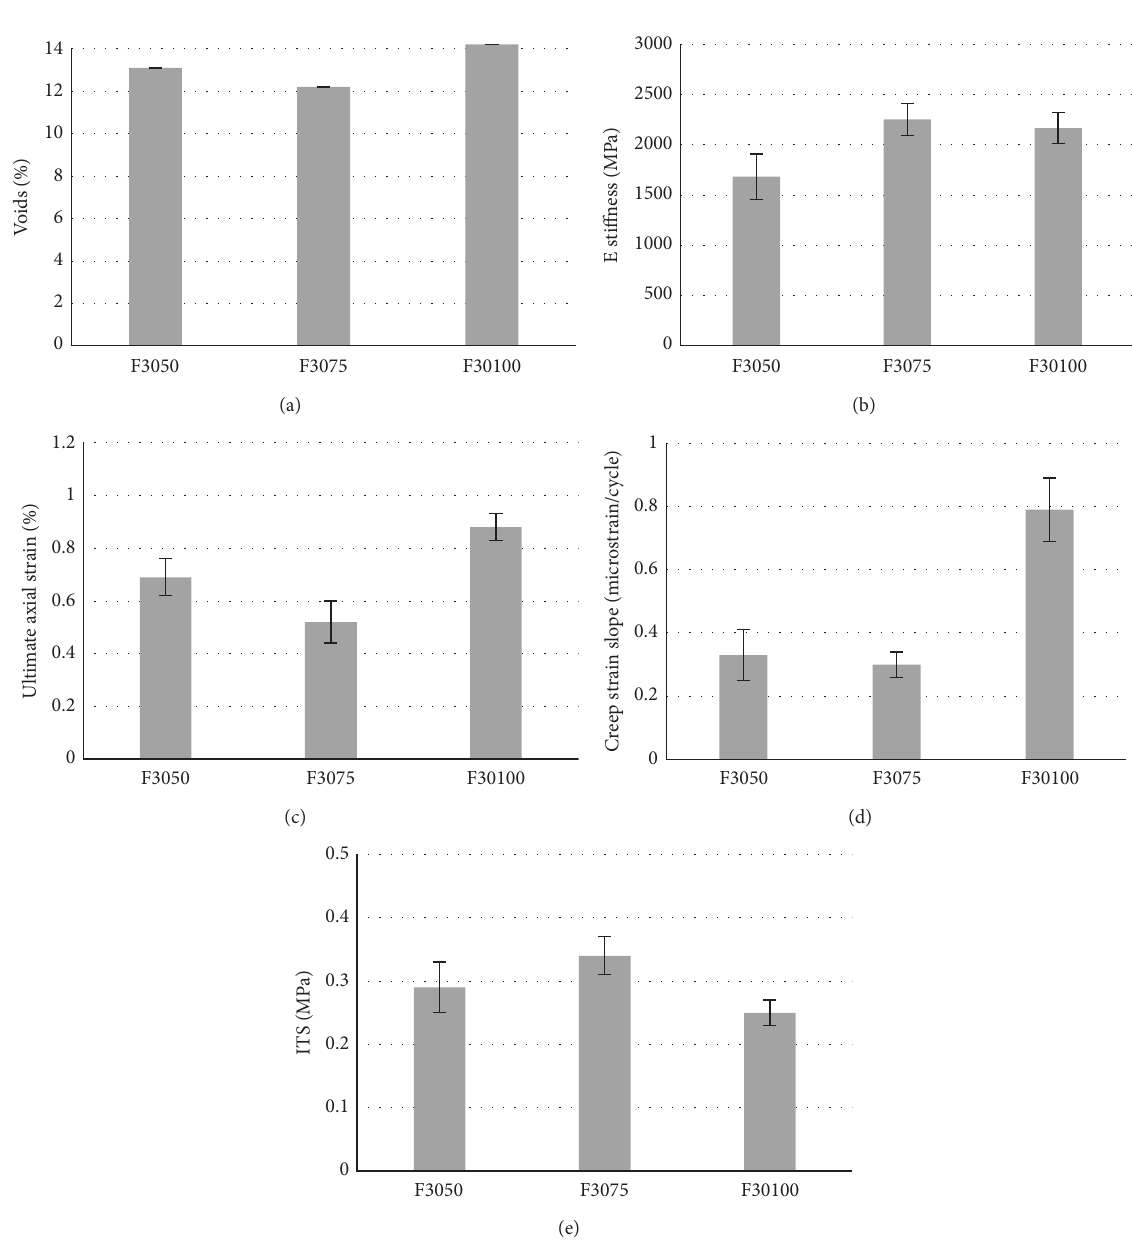
(15% lower than F4575, which showed the best